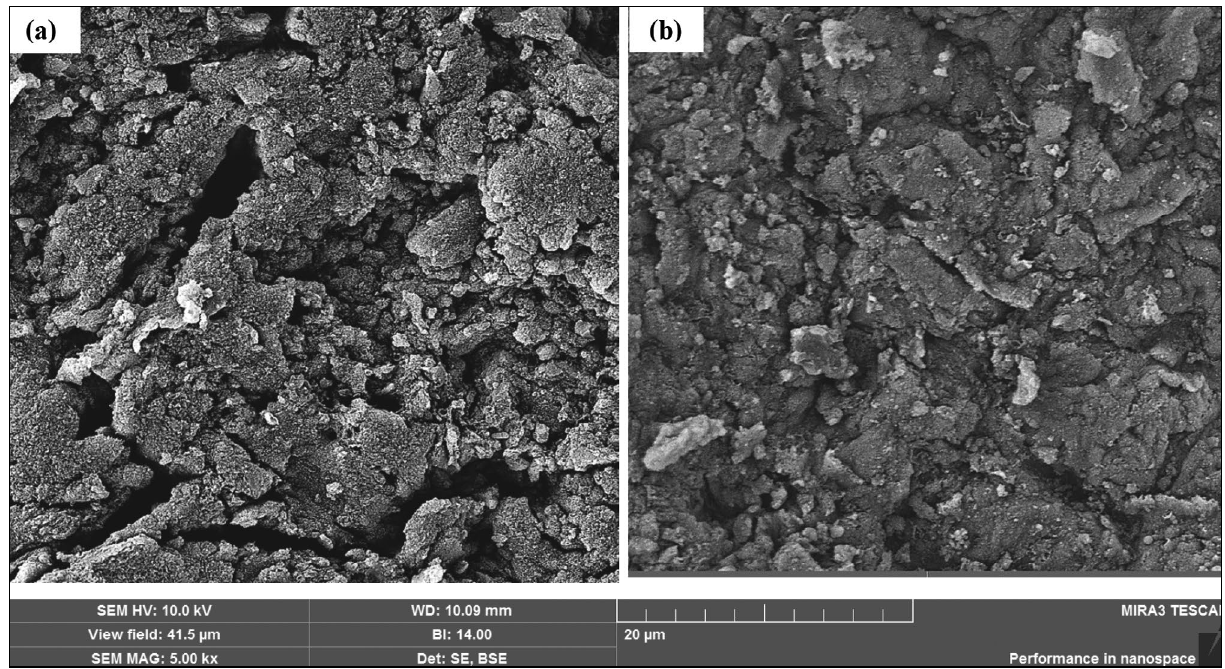
Fig. 3. SEM photograph of (a) uncoated AAPS and (b) AV 17 coated